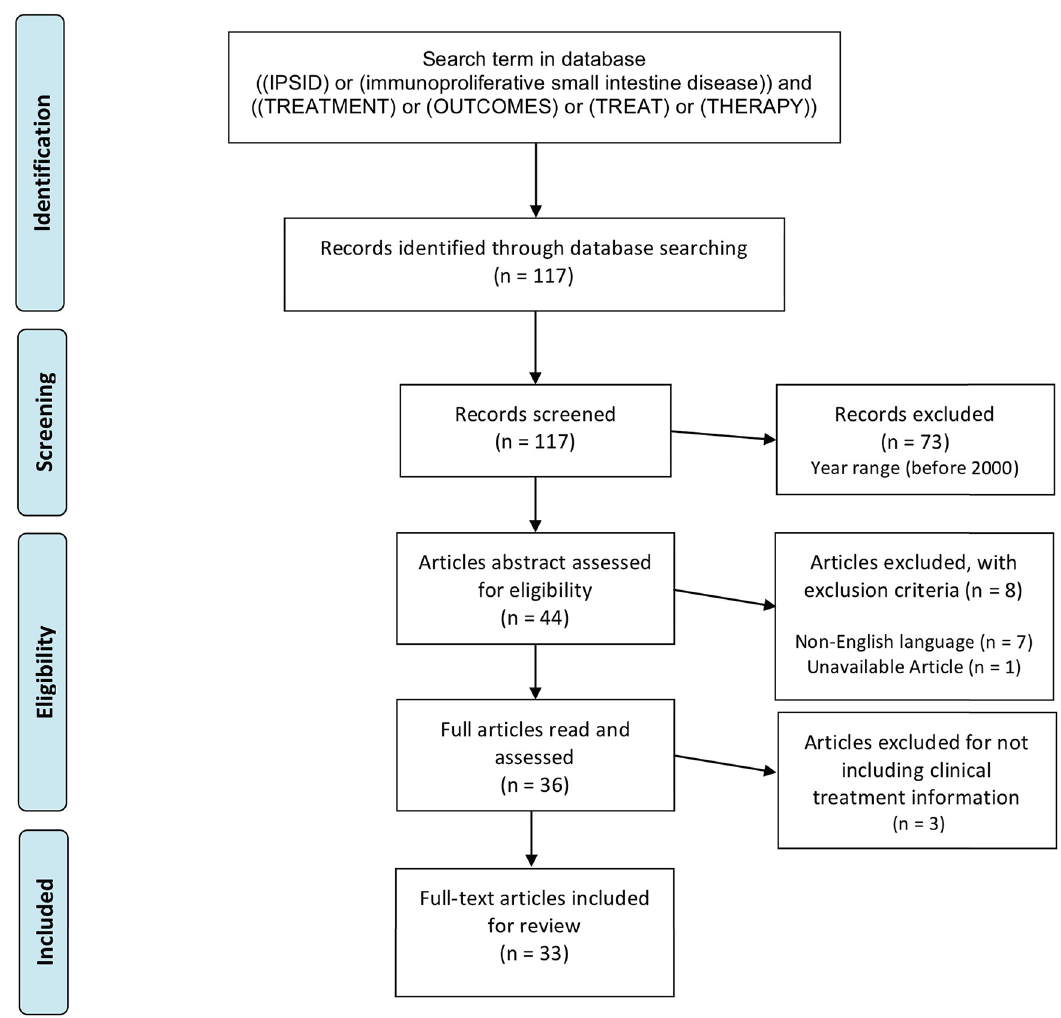
Fig 1. Inclusion and exclusion criteria following PRISMA